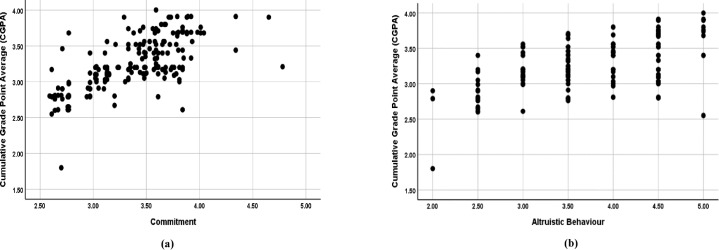
Correlation between the subdimensions of emotional intelligence and academic success.The scatterplots (a-b) undoubtedly represent the significant positive relationship among Commitment & CGPA; and Altruistic Behaviour & CGPA respectively.